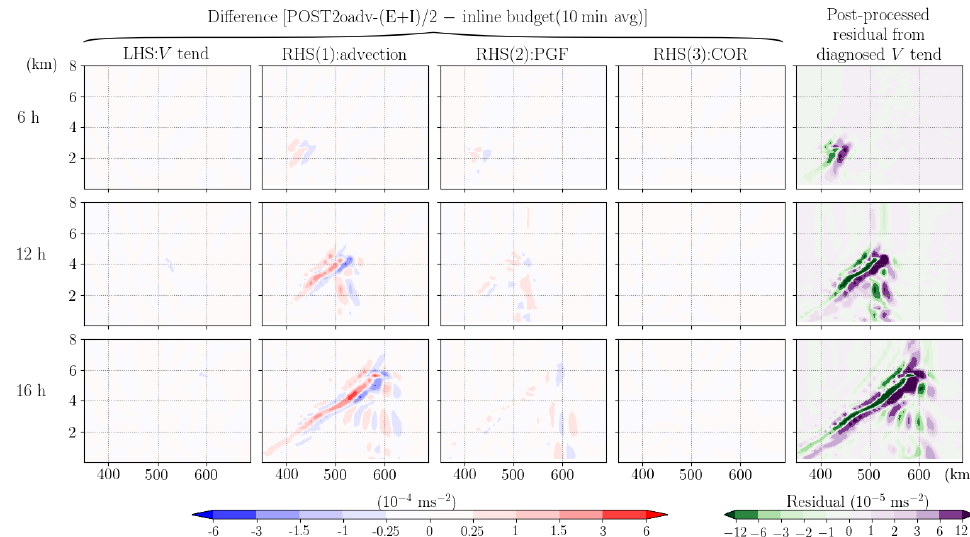
Figure 12. Same as Fig. 11, but the post-processed analysis uses a second-order operator for advection calculation